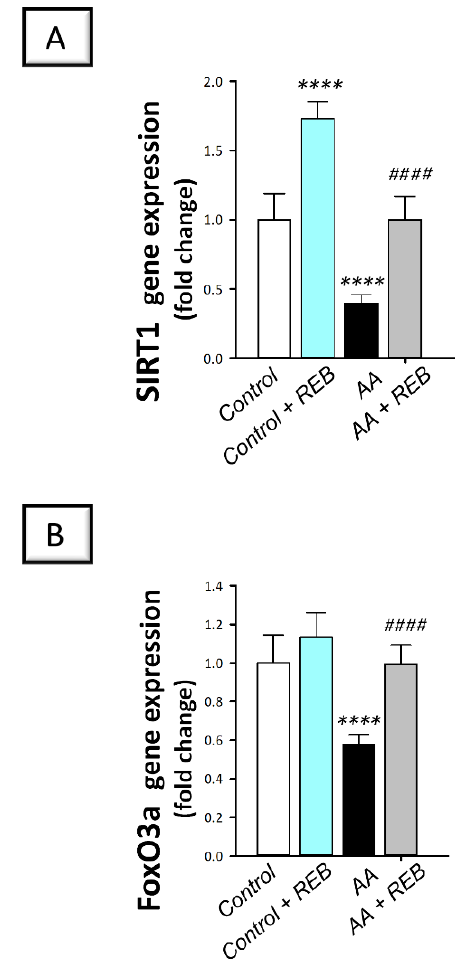
Figure 10. Rebamipide activates the colonic antioxidant SIRT1/FoxO3a pathway in rats exposed to acetic acid-induced colitis. ( A ) The gene expression levels of the silent information regulator 1 (SIRT1) in the colonic tissue. ( B ) The gene expression levels of forkhead box O3a (FoxO3a) in the colonic tissue. Each bar represents the mean ± S.D. ( n = 6). A one-way ANOVA statistical test was conducted to analyze the significant difference among tested groups followed by a Tukey’s test. **** p < 0.0001, significant from the control group. # ### p < 0.0001, significant from the colonic injury group. REB, rebamipide; AA, acetic acid.